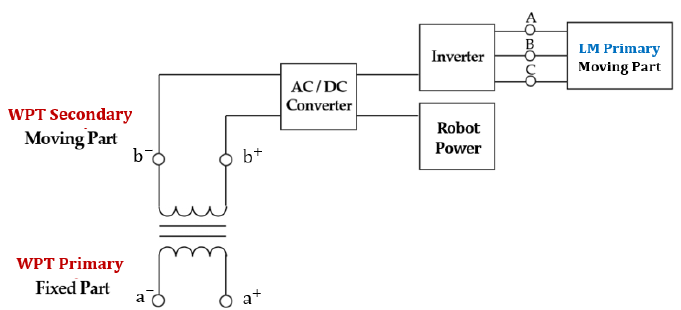
Figure 3. Concept diagram of the power system.